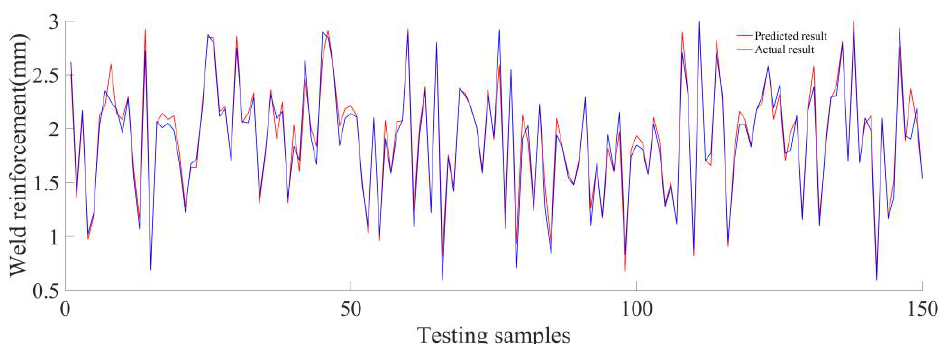
Figure 11. Predicted results of weld reinforcement.